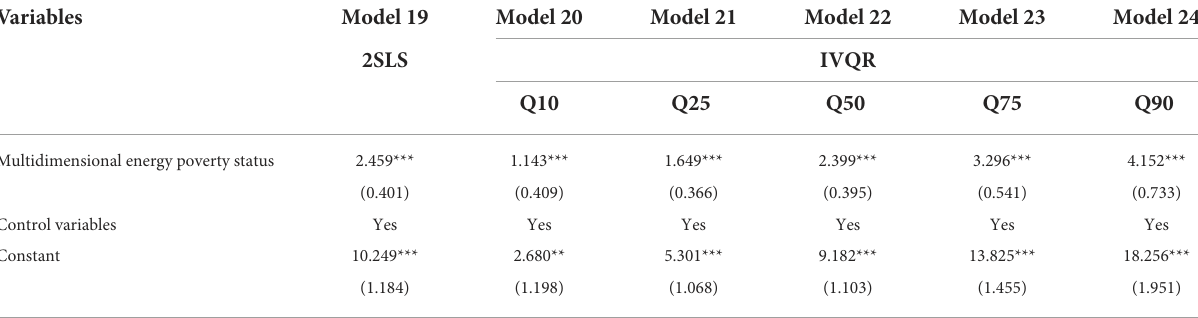
TABLE 6 Estimation results of instrumental variable regression models by replacing the core explanatory